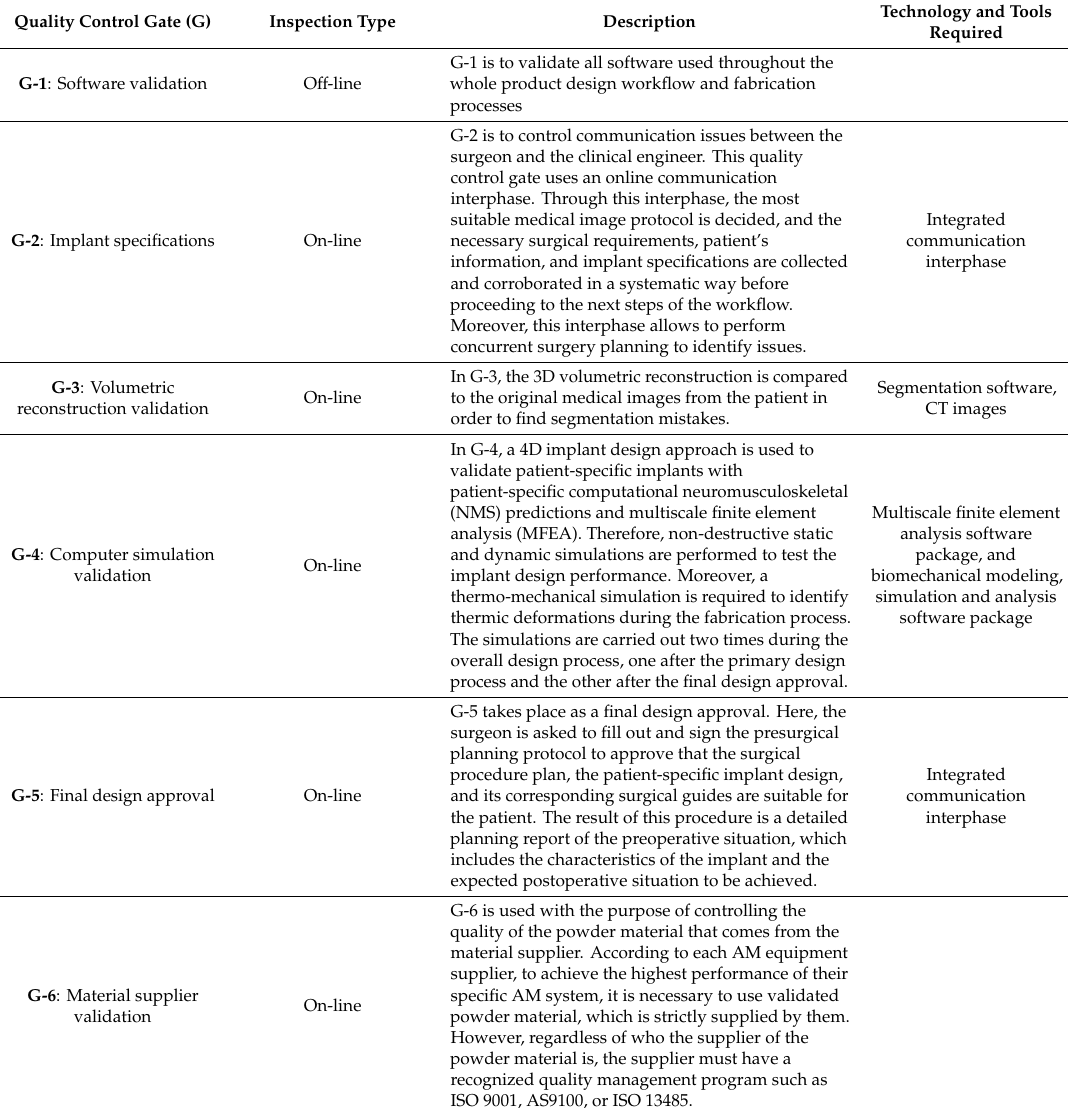
Table 8. Description and characteristics of the proposed integrated quality control flow